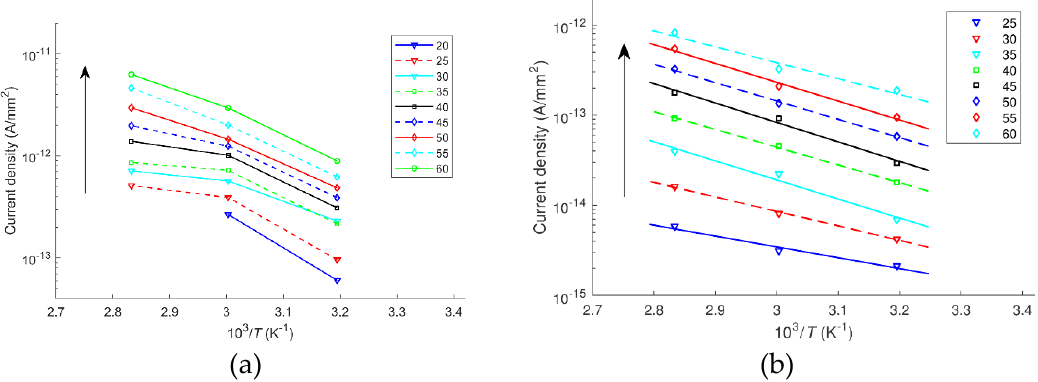
Figure 2. Temperature dependencies of the isochronal current densities recorded at 3 h (1.08×10 4 s) for (a) LDPE and (b) LDPE/Al 2 O 3 3 wt% nanocomposite at different applied electric fields (in kV/mm) - markers are the measured points, whereas lines represent the fitting. Arrows show the variation with the increasing field strength.